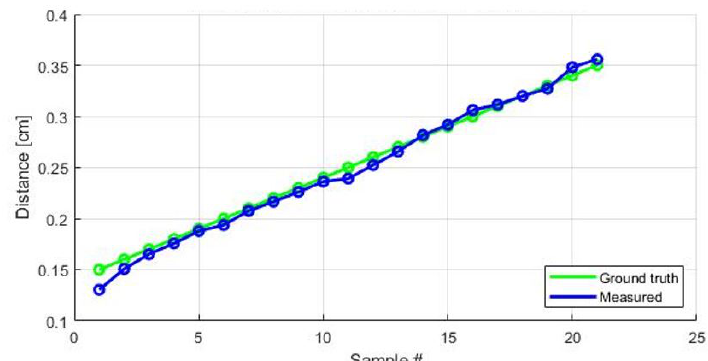
Figure 7. Ground truth distance vs reconstructed distance. Circular patches with diameter 3 cm are placed at distance 15 cm from each other and are moved apart from each other up to 35 cm. The green line is ground truth distance and blue line is reconstructed distance. The RMS error of total 21 sample is 0.03 cm.